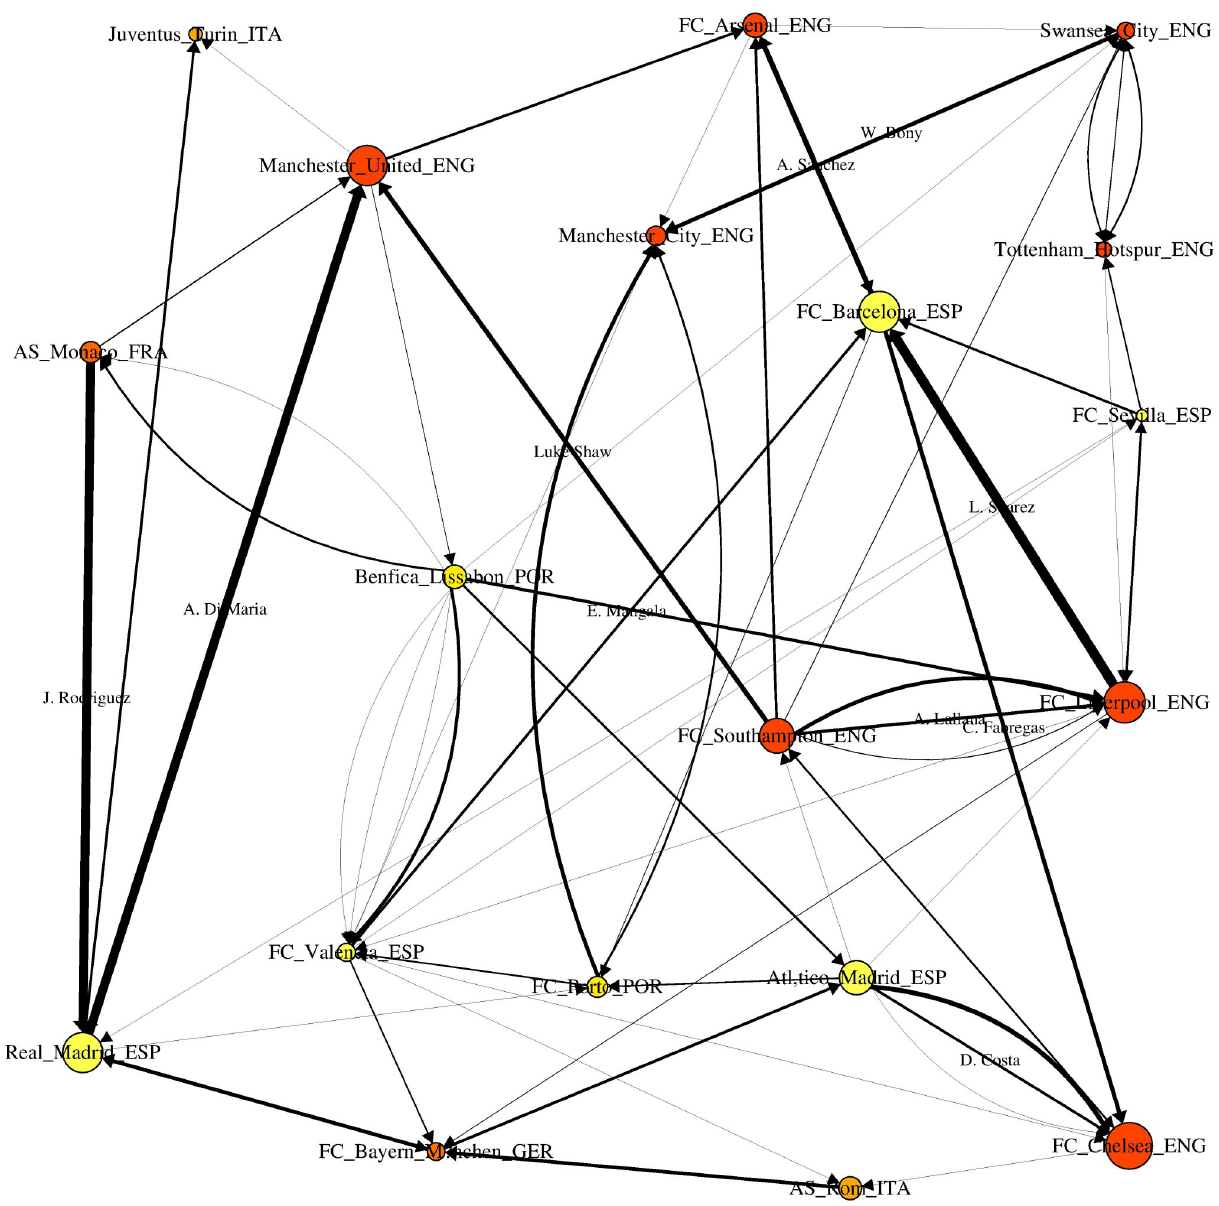
Fig 1. Transfer sub-network for season 2014/2015. Transfer market activities among clubs that have transferred players (in and out) with an overall transfer fee volume greater than € 70 million are illustrated. Nodes’ (clubs’) colors correspond to the league, while node sizes correspond to the total transfer fee volume traded by every club. The widths of links are proportional to player costs. Only the names of players transferred for more than € 30 million are displayed.